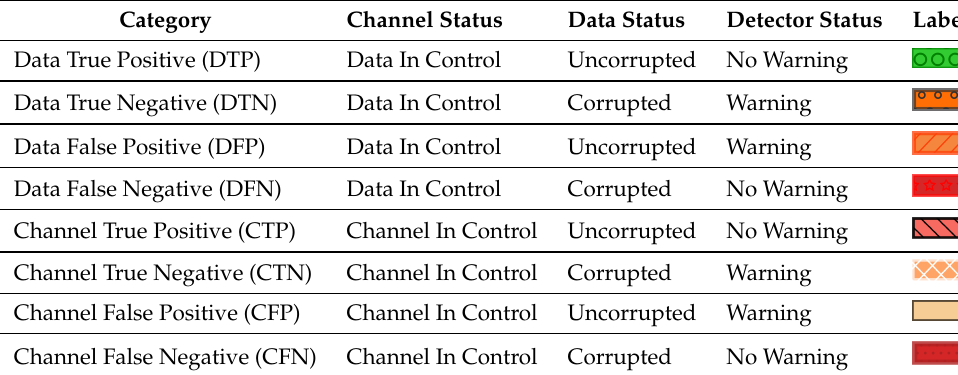
Table 1. An overview of the considered